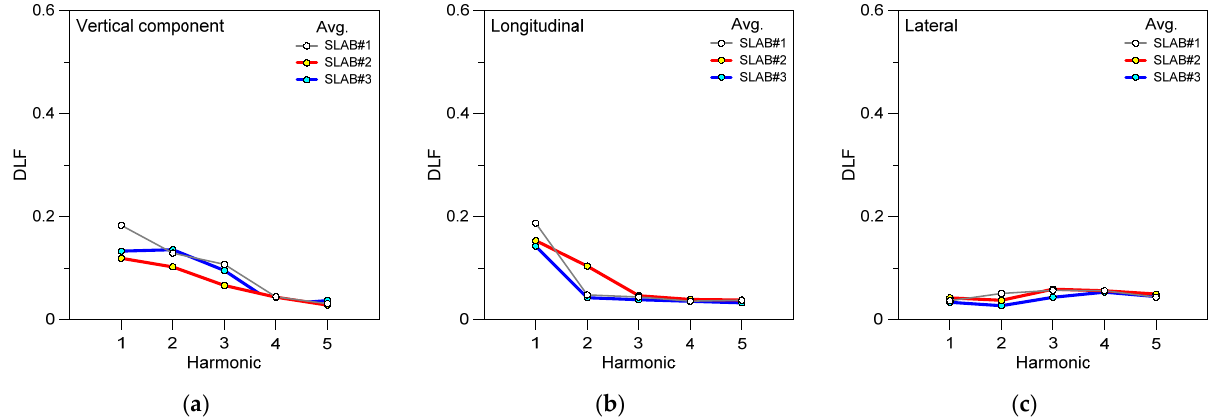
Figure 8. Experimentally derived DLF trends (average), as a function of harmonic order, for a single adult volunteer under normal walks on rigid floor (SLAB#1) or flexible SLAB#2 and SLAB#3 transparent systems, with evidence of ( a ) vertical, ( b ) longitudinal, and ( c ) lateral force components based on body CoM measurements. Average DLF values calculated based on eight walking records for SLAB#1, 10 for #2 and nine for #3.